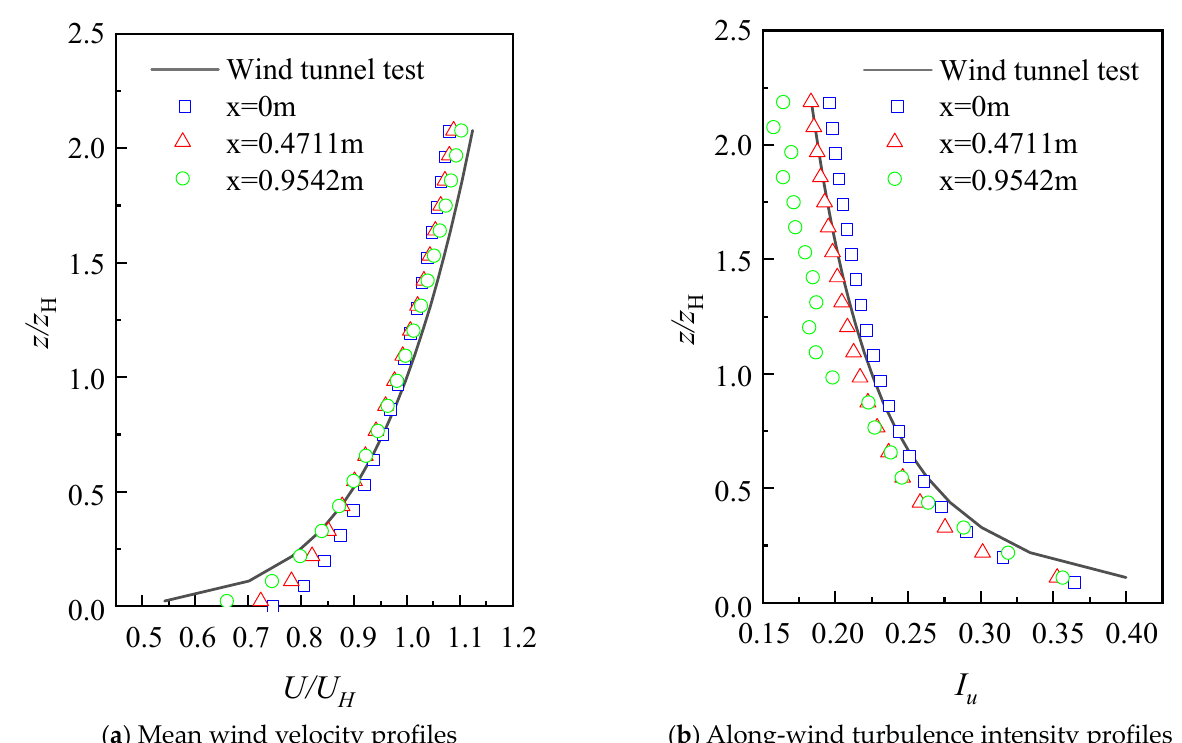
Figure 12. Mean wind velocity and turbulence intensity profiles at different locations.